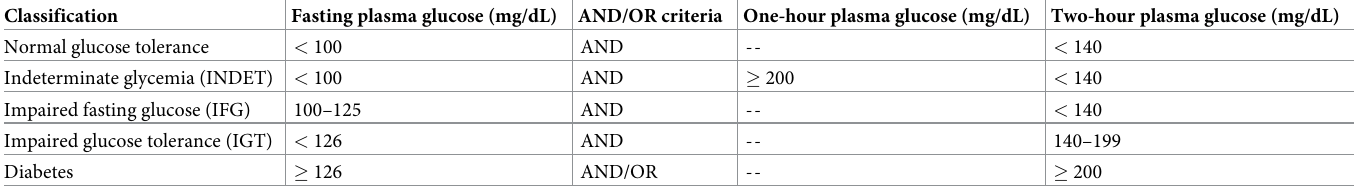
Table 1. Classification of glycemic states based on oral glucose tolerance test results.